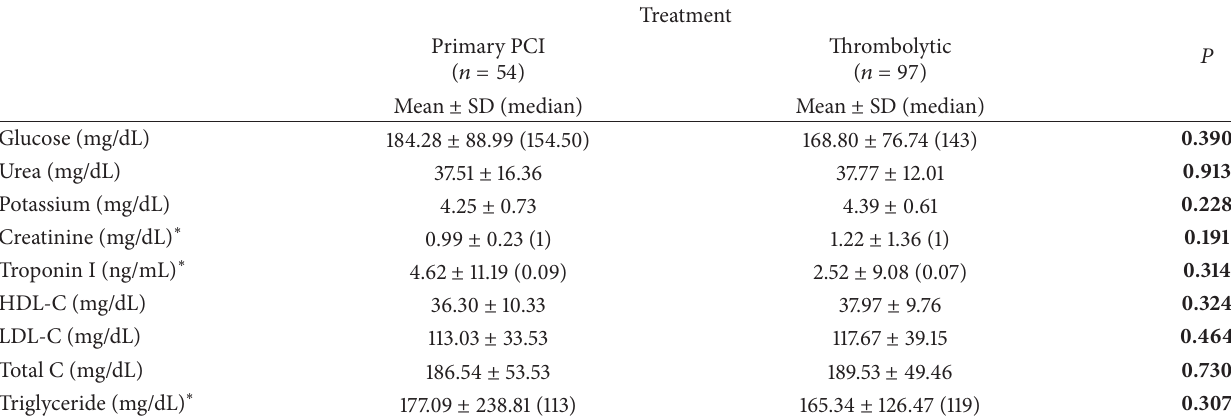
Table 2: Laboratory measures of